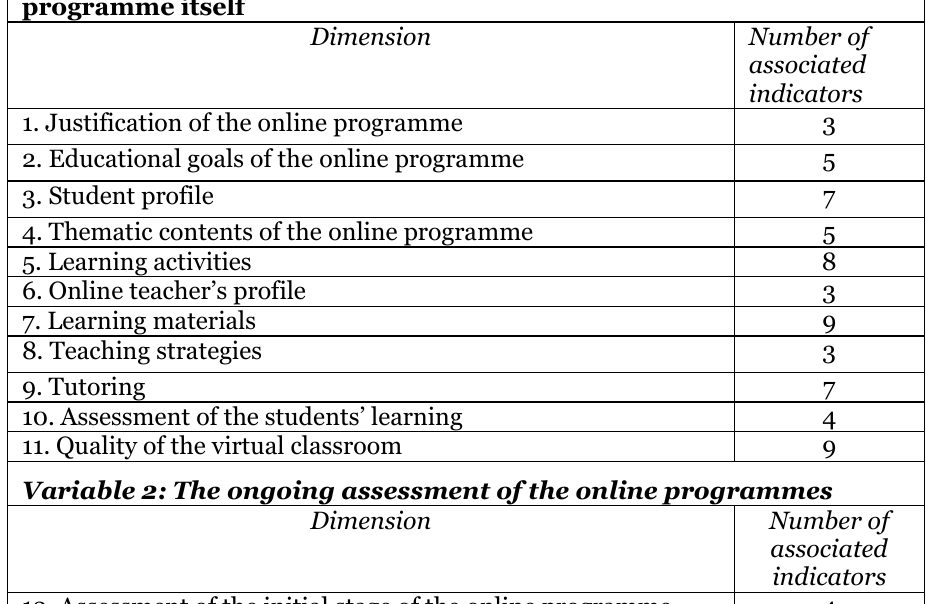
Distribution of the Indicators Based on the Proposed Dimensions Variable 1: The assessment of the quality of the e-learning education programme itself